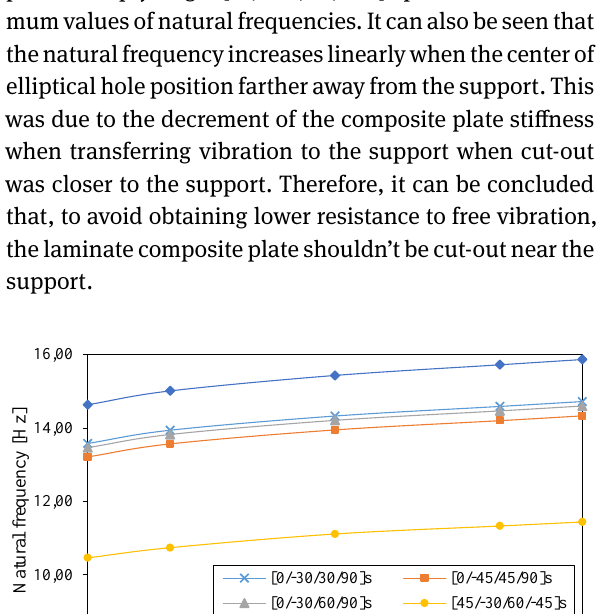
Figure 7: Effect of hole position on the natural frequency (a/b = 0.5; ϕ = 45; BC =